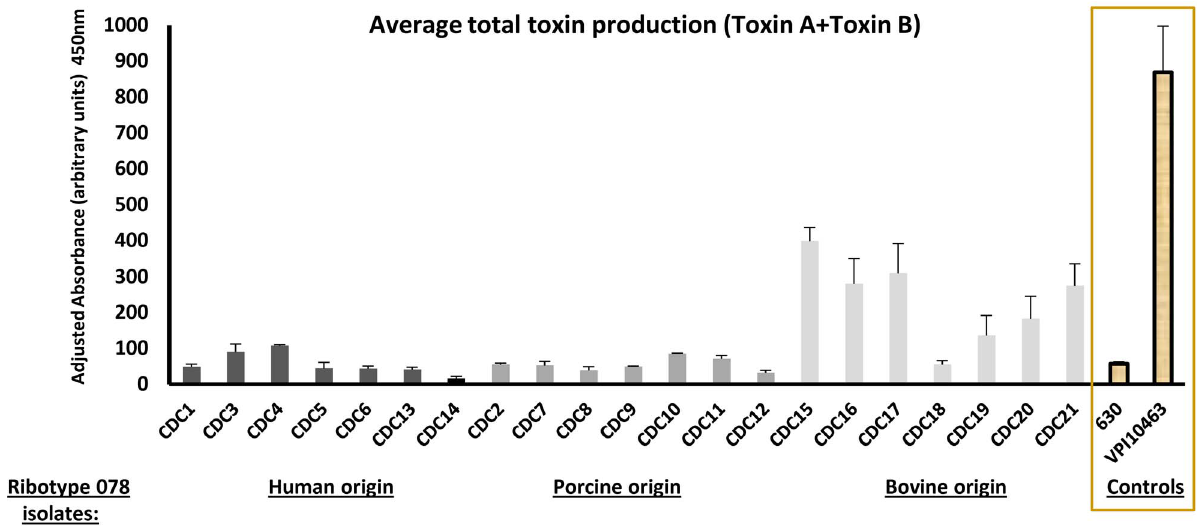
Figure 4. Toxin production of ribotype 078 isolates. Toxin testing was performed as described in the Methods section. As above, isolates were divided into those of human origin (dark gray bars; 7 total); porcine origin (medium gray bars; 7 total) and bovine origin (light gray bars; 7 total). Two biological replicates of each strain were assayed, and each toxin measurement was obtained in triplicate. The clinically uncommon low toxin producing strain 630 and high toxin producing strain VPI 10463 (clear bars) were used as internal